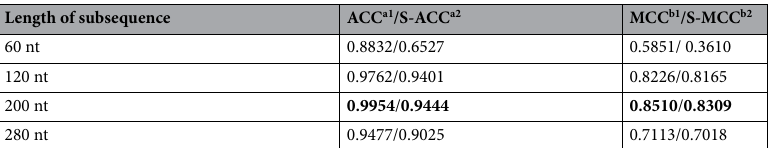
Table 6. The performance of RNA-par models under different length of subsequences on TS dataset. The best performance was highlighted in bold. a1 accuracy, a2 segment-based accuracy, b1 Matthews correlation coefficient, b2 segment-based Matthews correlation